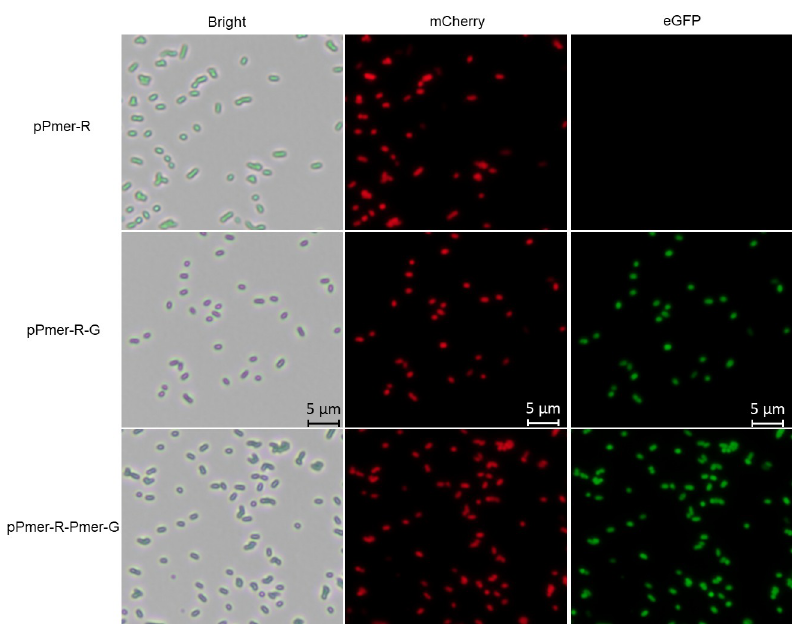
Fig 5. Fluorescence images of three mercury biosensors exposed to 400 μ M Hg(II) at 37˚C for 12 h. E . coli cells were visualized using a fluorescence microscope ( × 600 magnification). The mCherry expression was visualized with a Texas Red filter, and the eGFP expression was visualized with a FITC filter. Three independent preparations were analyzed, and representative images are shown here.